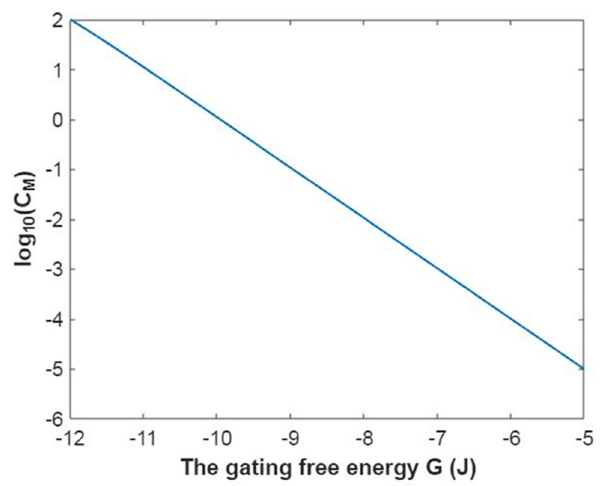
Figure 4. The relationship between gating free energy and the common logarithm of the membrane conductance of sodium ions according to the Boltzmann distribution at membrane potential − 0.087 V and over gating free energy range from − 12 J to − 5